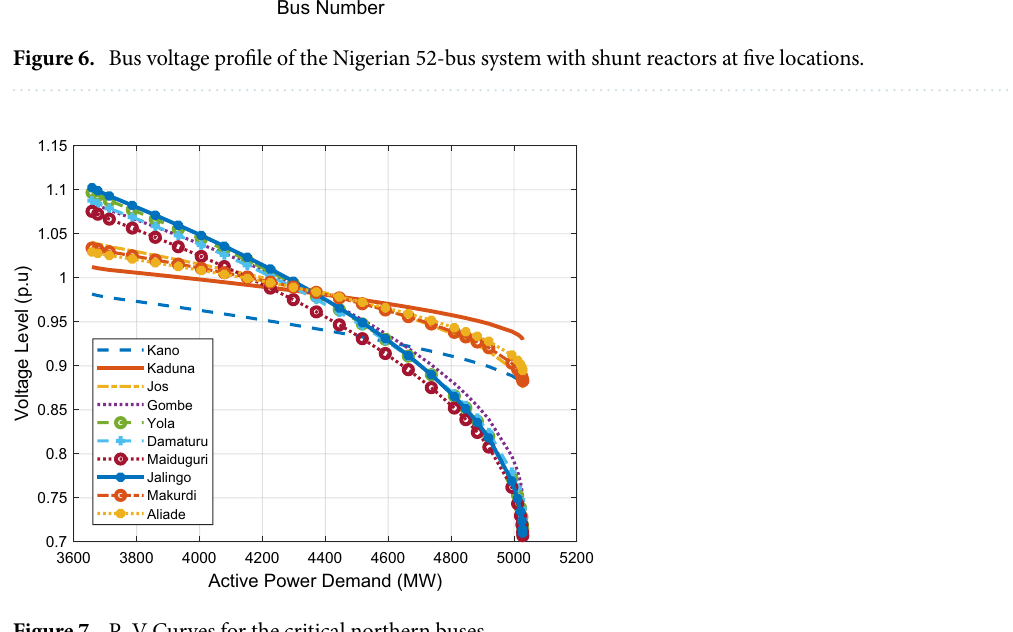
Figure 7. P–V Curves for the critical northern